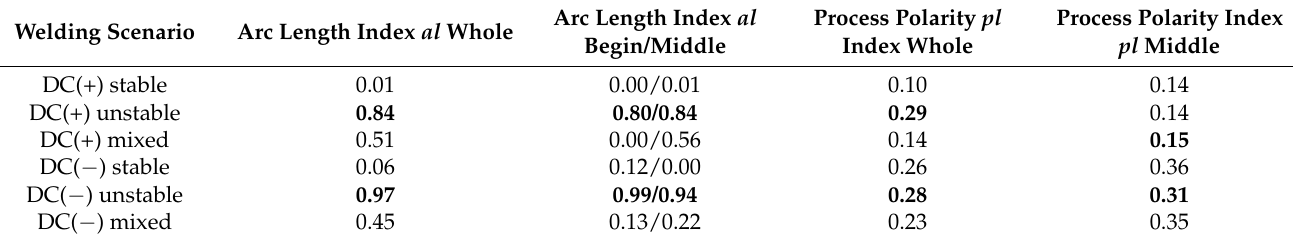
Table 3. Arc length and polarity index values calculated for raw arc length indicator and polarity indicator